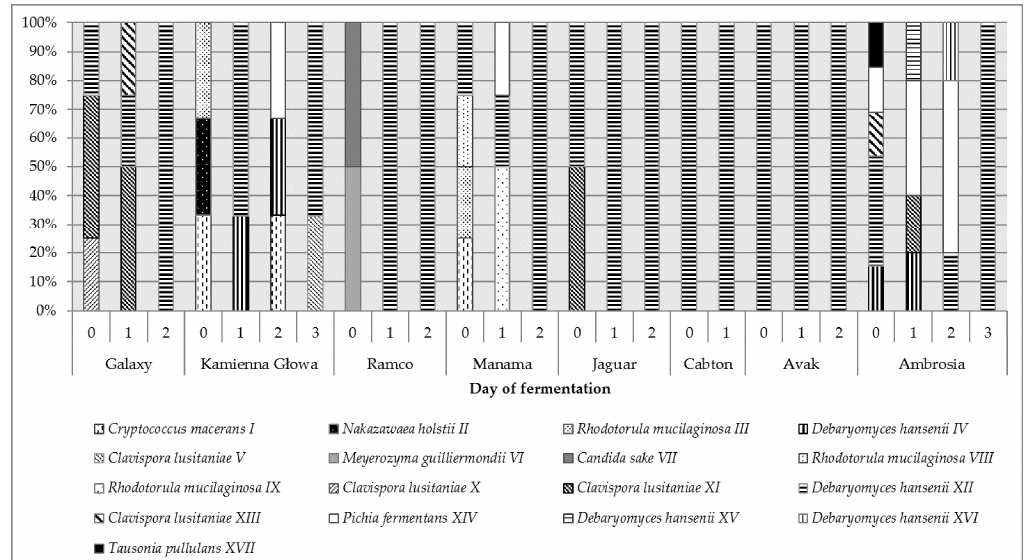
Figure 3. Distribution of yeast strains (%) isolated from the initial stage of different cultivars of cabbage fermentation.